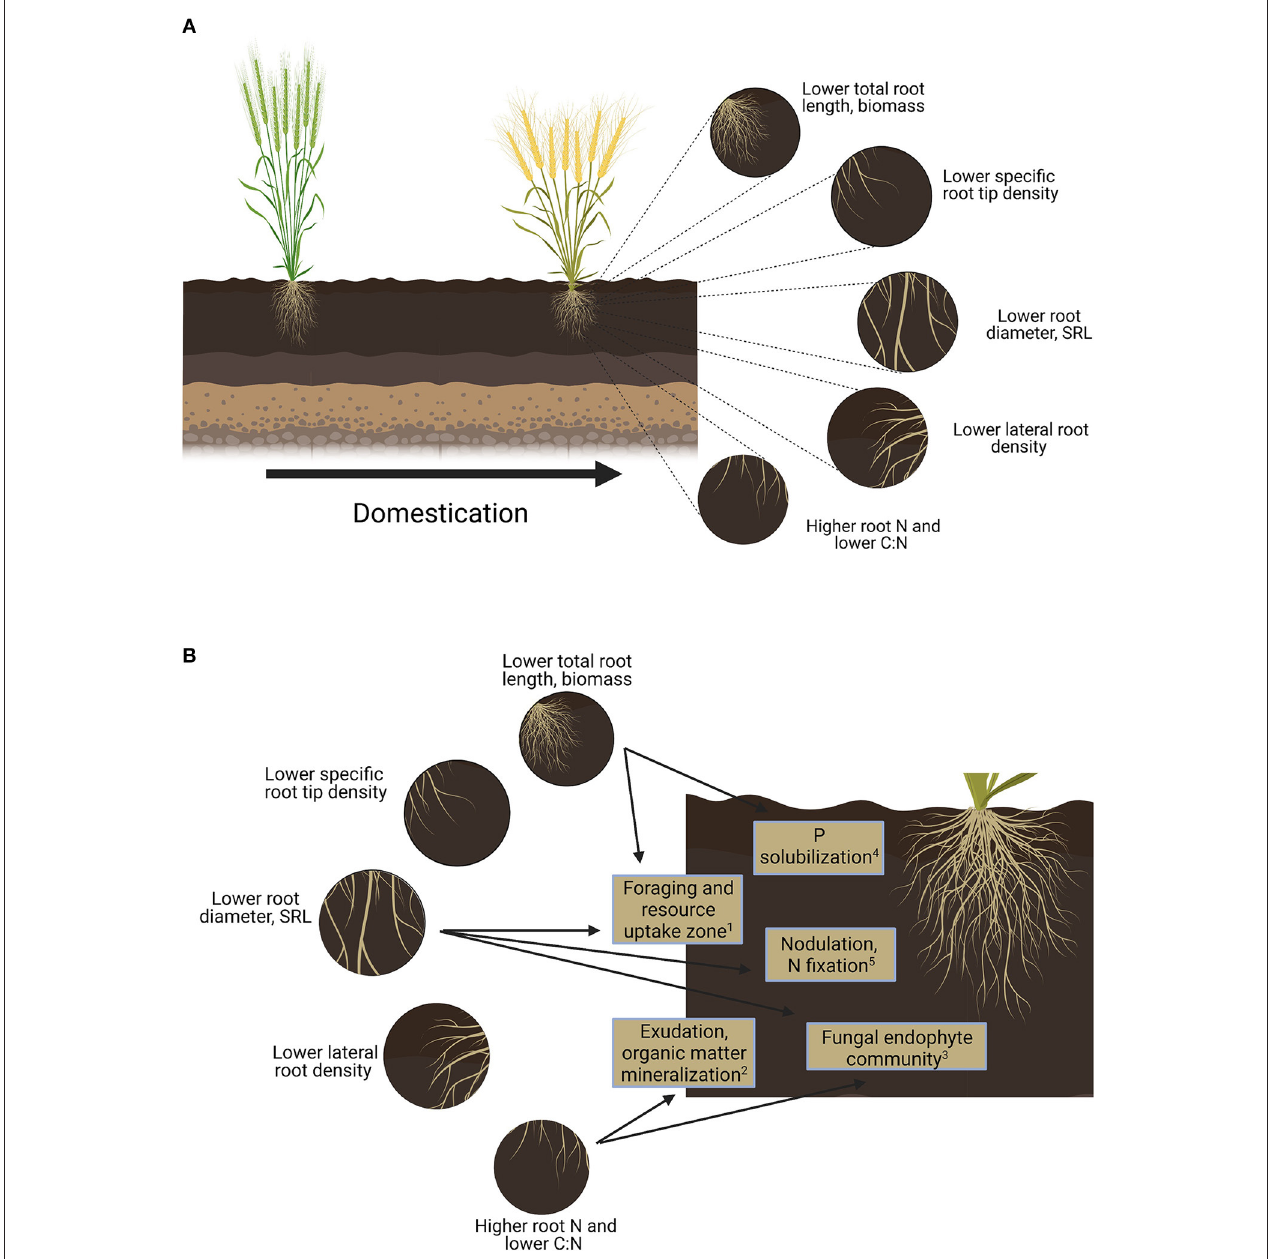
FIGURE 1 | Hypothesized root functional trait syndromes via selection through domestication (A) and hypothesized effects of selected root traits on rhizosphere functions (B) . This figure was created with BioRender [ 1 Cahill et al., 2010; 2 Herz et al., 2018; 3 Fulthorpe et al., 2020; 4 Bargaz et al., 2017; 5 Martin et al., 2019].